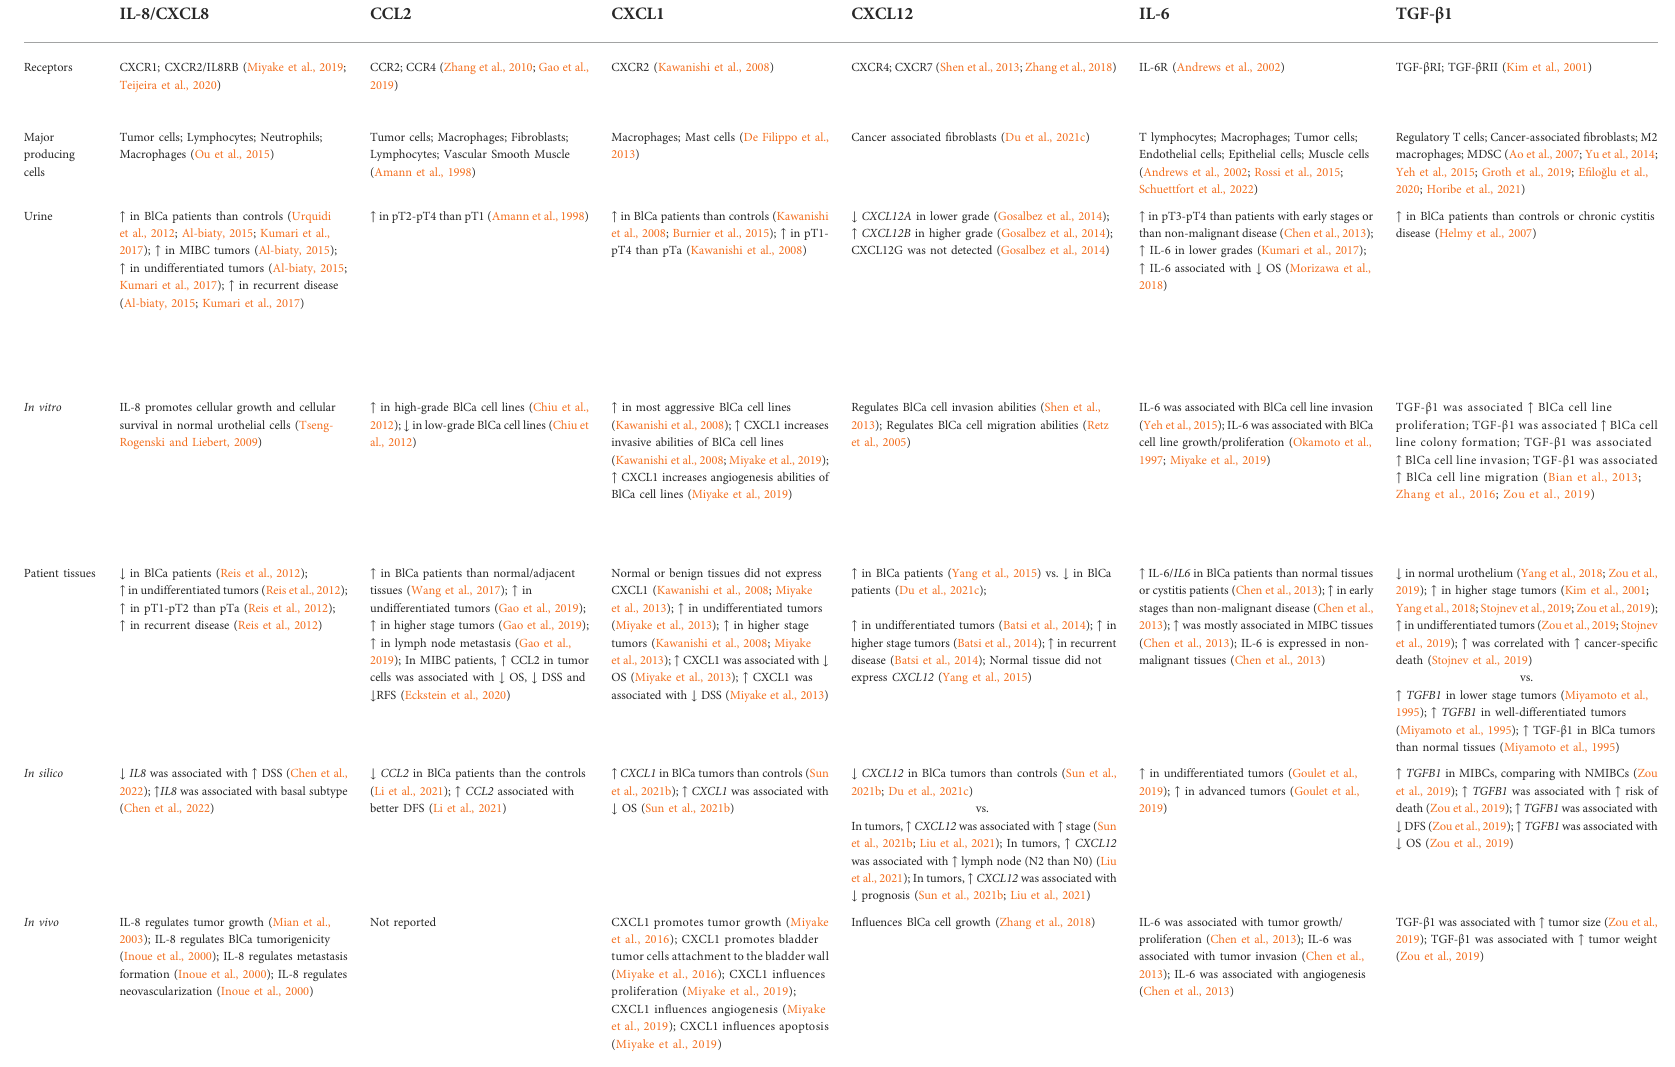
TABLE 1 Cytokines/chemokines levels are deregulated during BlCa progression, growth, invasion, and metastases